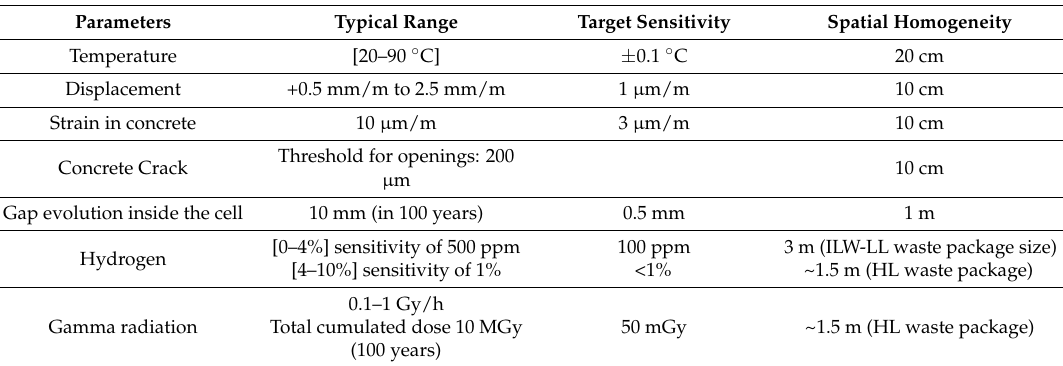
Table 1. Main parameters to be monitored in the underground repository.